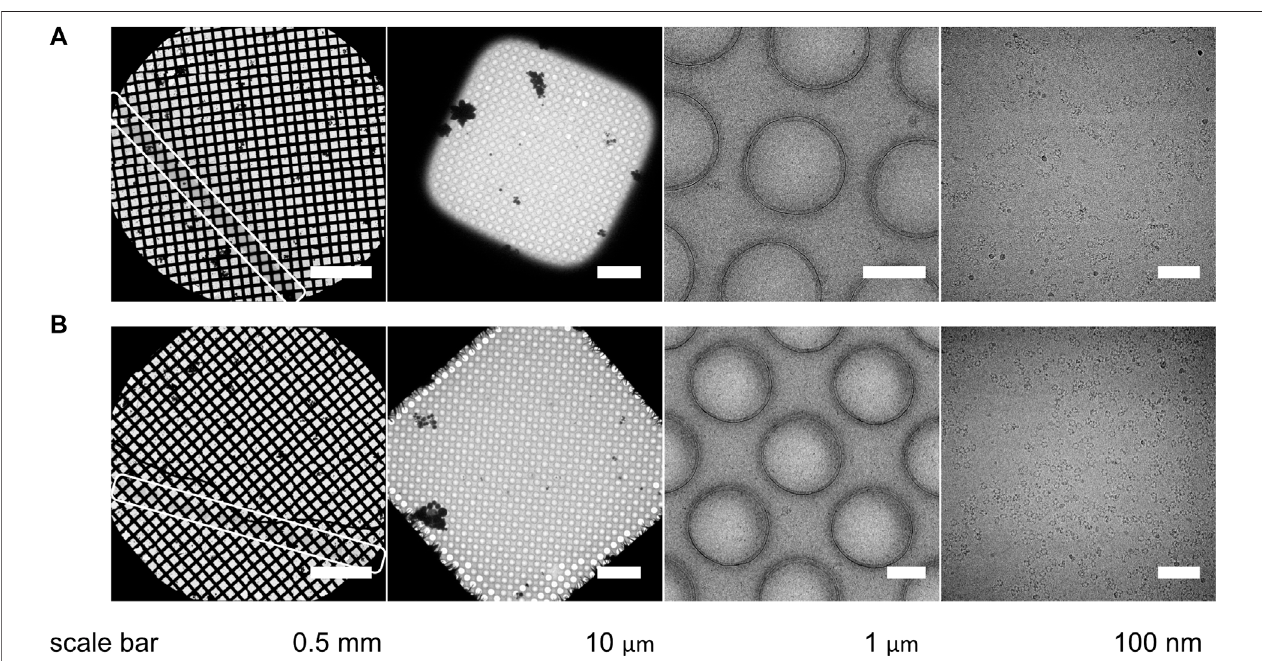
FIGURE 8 | Atlas, grid square, foil hole, and micrograph level images of two different chameleon-plunged grids with the same sample. (A) A grid with thicker ice (note the square shown here is not representative of most of the squares within this stripe). (B) A grid with thinner ice. The stripes in the atlas-level view are indicated by white rectangles; scale bars are indicated at the